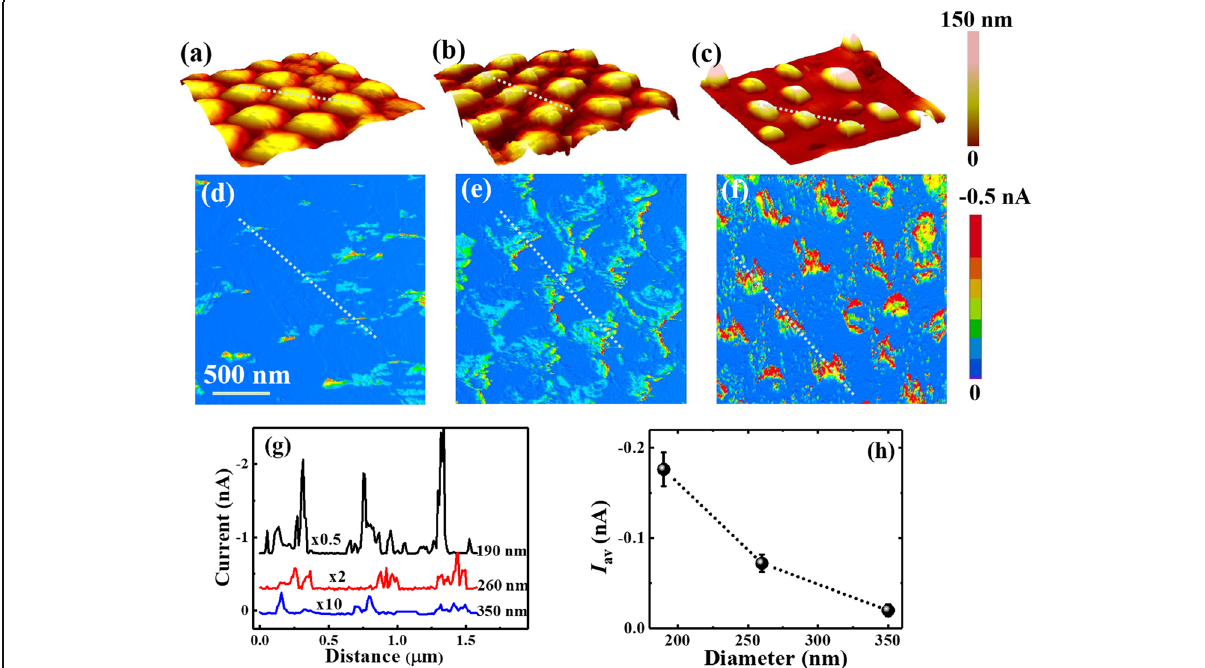
Fig. 4 The topography images of Si NWs with the same length of 350 nm but different diameters of a 350 nm, b 260 nm, c 190 nm. Their corresponding current images obtained under the sample bias of − 1.5 V are given in d , e and f , respectively. Current profiles along the marked lines in d – f are plotted in g , and h presents the averaged current ( I av ) over the nanowires as a function of NWs ’ diameter. Corresponding lines are added in the topography images of a – c and the profile curves in g are vertically shifted for guidance